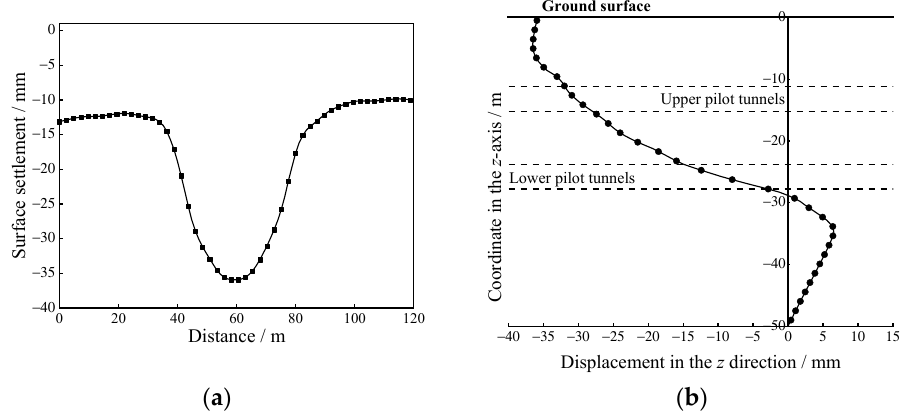
Figure 14. Ground settlement caused by seismic excitation:( a ) ground surface settlement ( b ) ground displacement in the z direction.